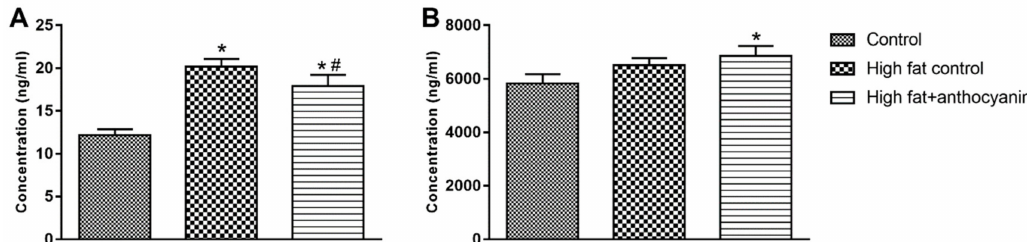
Figure 8. E ff ect of chronic anthocyanin treatment on the plasma levels of resistin (Panel A ) and adiponectin (Panel B ). The * indicates a significant di ff erence ( p < 0.05) from the control group. The # indicates a significant di ff erence ( p < 0.05) between the high fat control and the high fat + anthocyanin